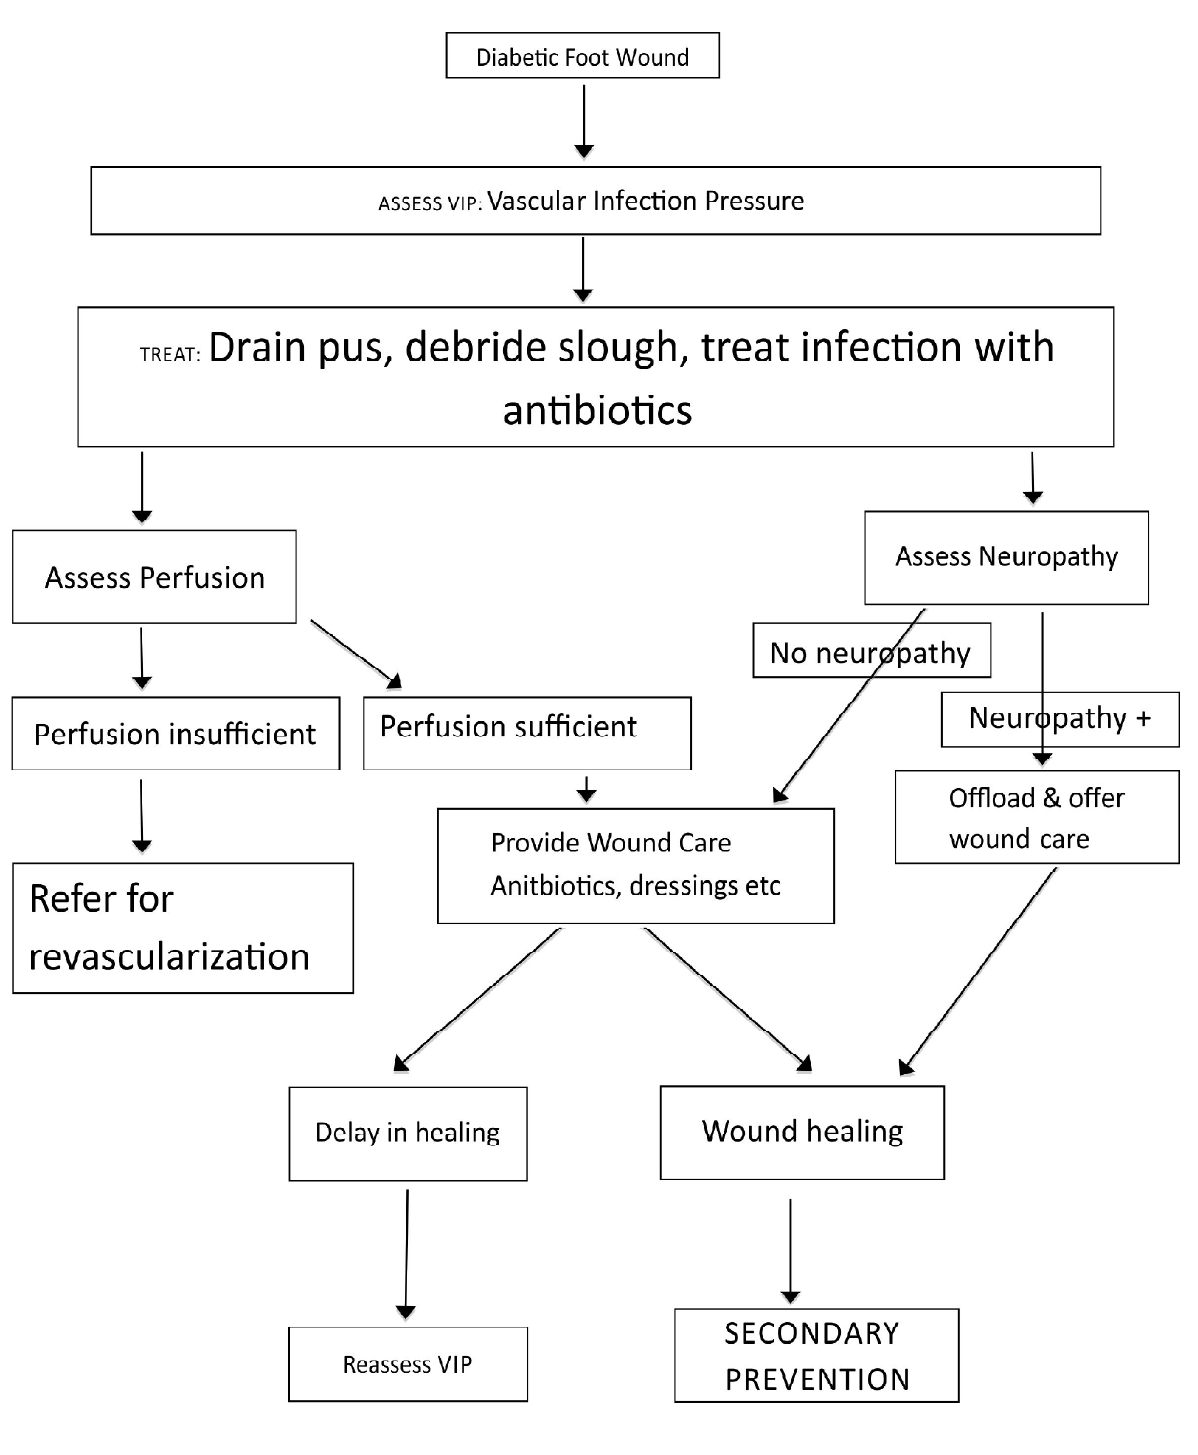
Medical treatment